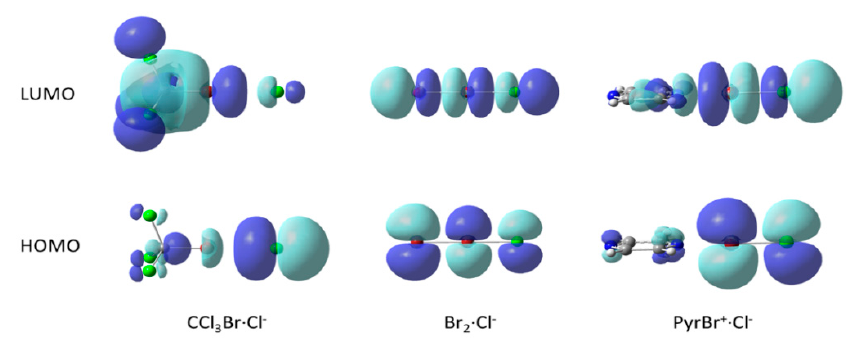
Figure 8. Variations in the Highest Occupied Molecular Orbital (HOMO) and Lowes Unoccupied Molecular Orbital (LUMO) shapes in the associations between R-Br electrophiles and Cl − anions.